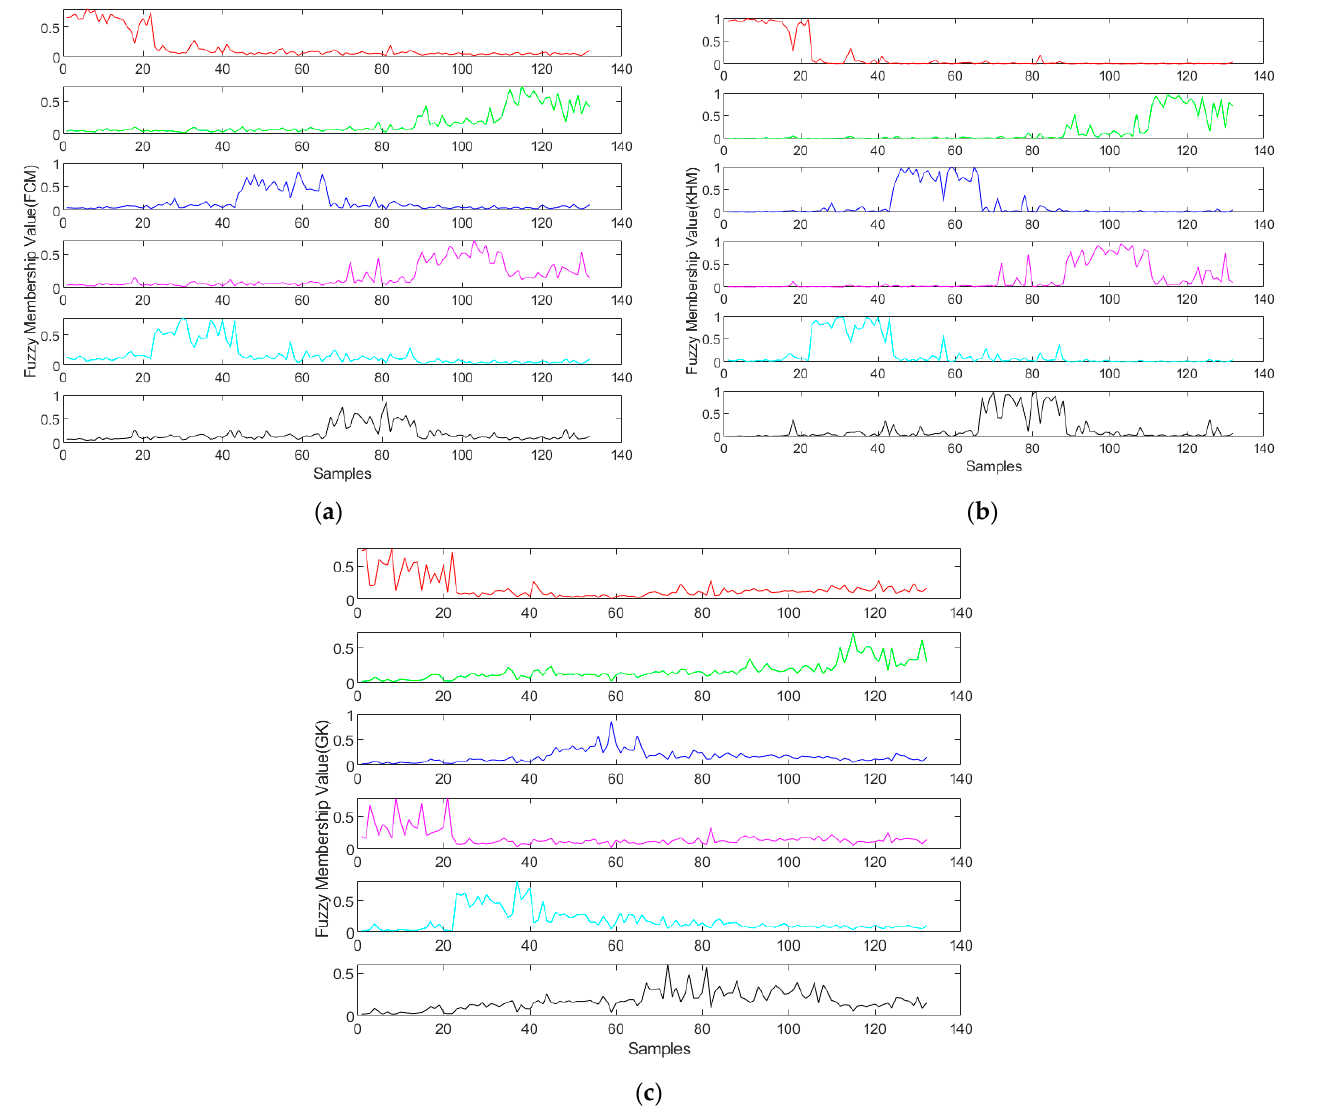
Figure 3. The fuzzy membership values of the samples in 6 days by fuzzy clustering algorithms: ( a ) FCM, ( b ) KHM, and ( c ) GK. ( a ) FCM, ( b ) KHM, and ( c )